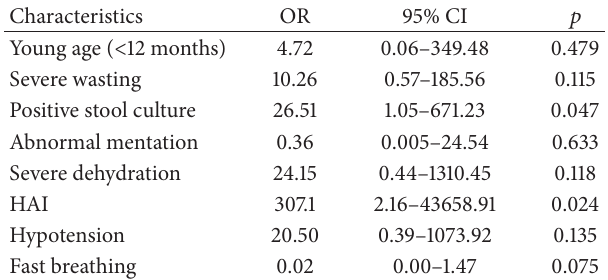
Table 3: Bacterial isolates from stool culture. Organism